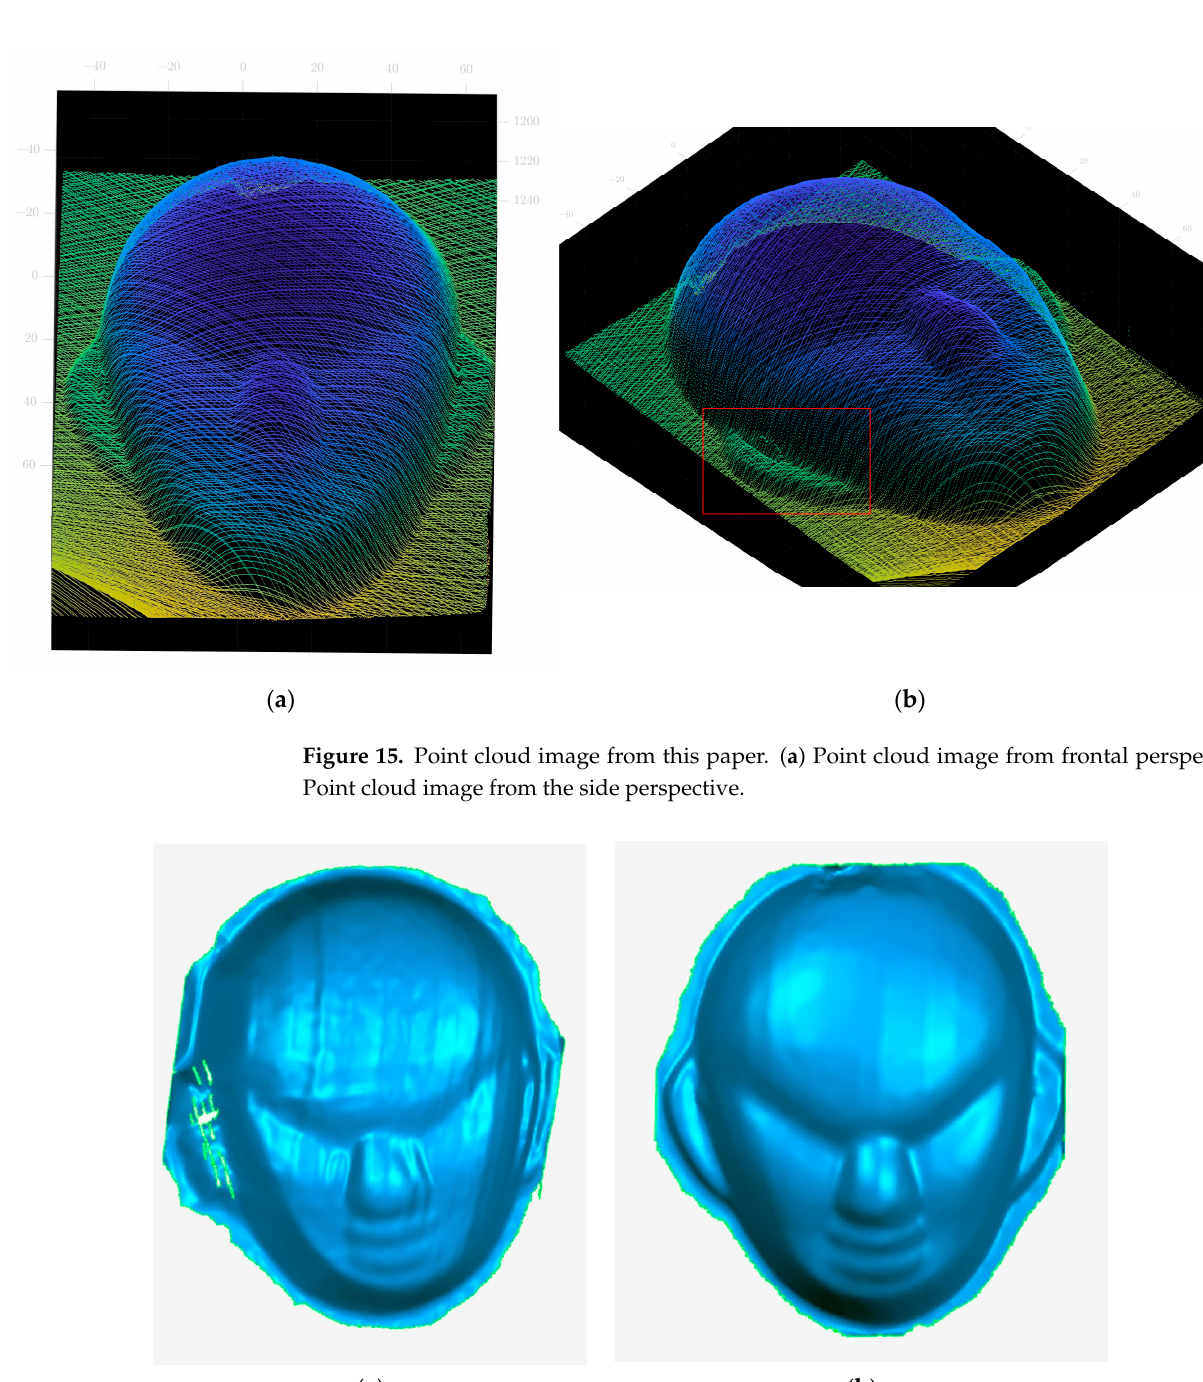
Figure 14. Traditional method of measurement. ( a ) Face mask model from camera view. ( b ) Point cloud image from the traditional method.